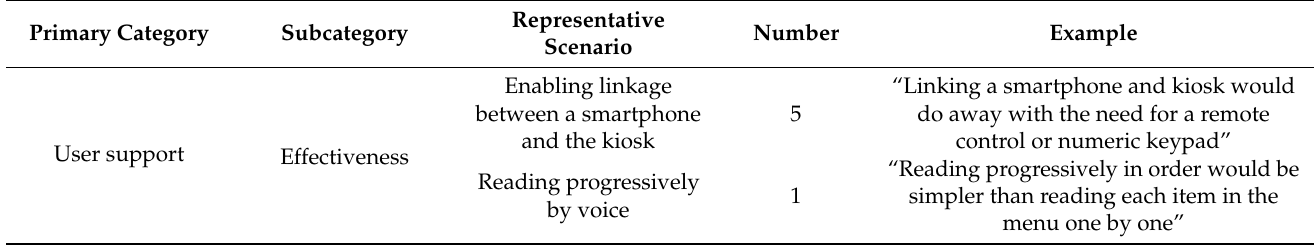
Table 6. Usability items for participants with visual